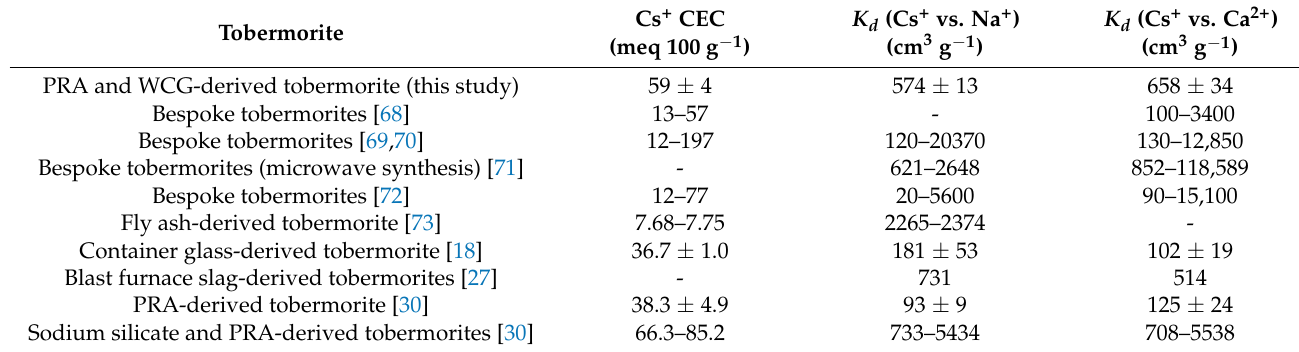
Table 5. Cs + cation exchange capacity (CEC) and selective Cs + distribution coefficients ( K d )